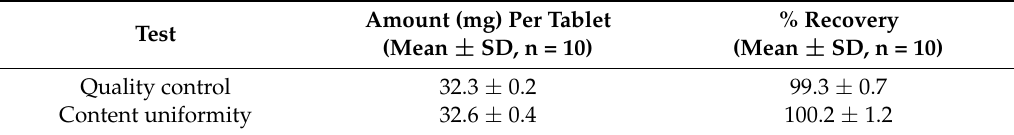
Table 4. Risedronate quantitation in a commercial